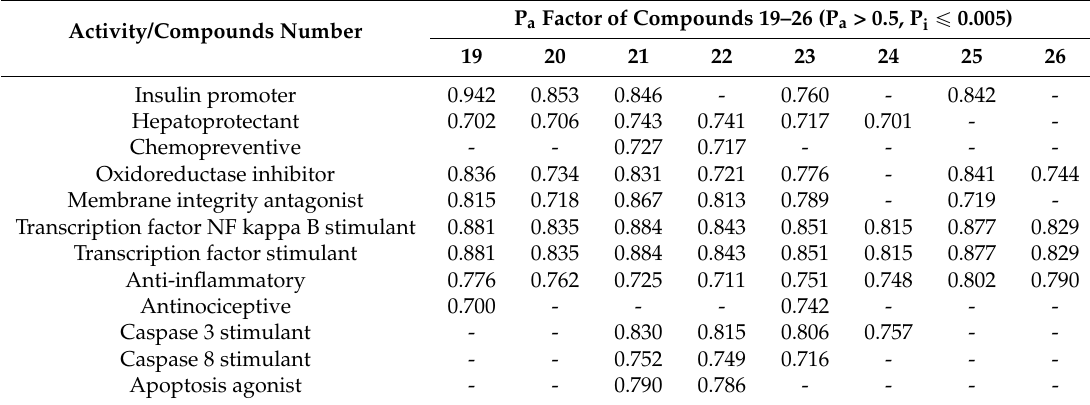
Table 2. Predicted activity of iminoester-type derivatives 19 – 26 determined by the PASS method. Activity/Compounds